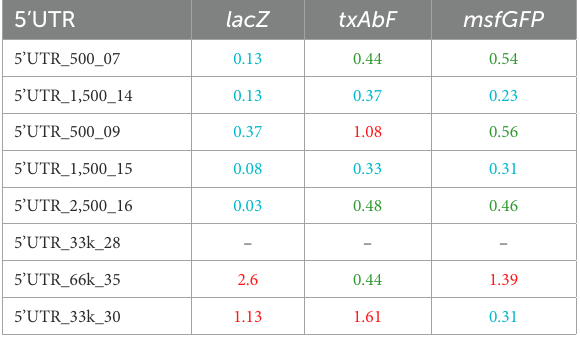
TABLE 1 Degradational regulation coefficients ( ρ D) of constructs with eight different 5’UTRs and three reporter